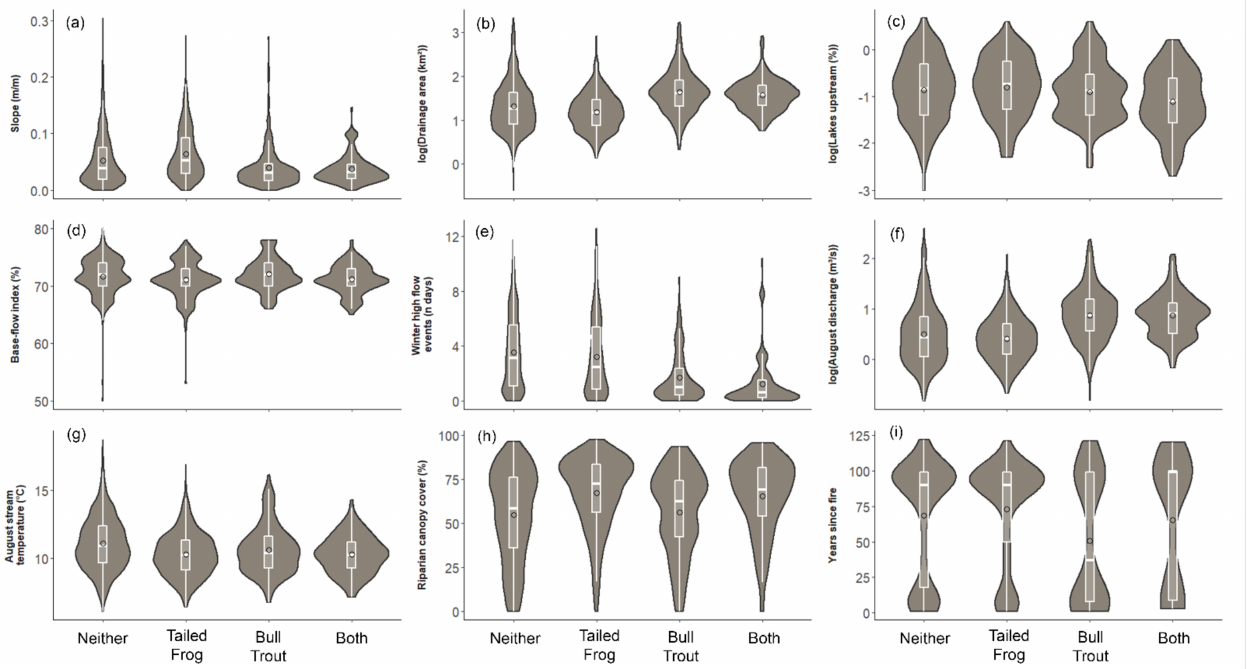
Figure 6. Distribution of stream characteristics ( a – i ) across each of four species occupancy categories: Sites where neither tailed frogs nor bull trout were detected ( n = 1684 Neither sites), sites occupied by tailed frogs but not bull trout ( n = 664 Tailed Frog Only sites); sites occupied by bull trout but not tailed frogs ( n = 331 Bull Trout Only sites), and sites occupied by both tailed frogs and bull trout ( n = 150 Both sites). The violin plots show a smoothed frequency distribution of all sites across each variable (density plot width), as well as the median (white line), mean (circle), 25th and 75th percentiles (ends of box), and minimum and maximum (white lines depicting 1.5 × the inter-quartile